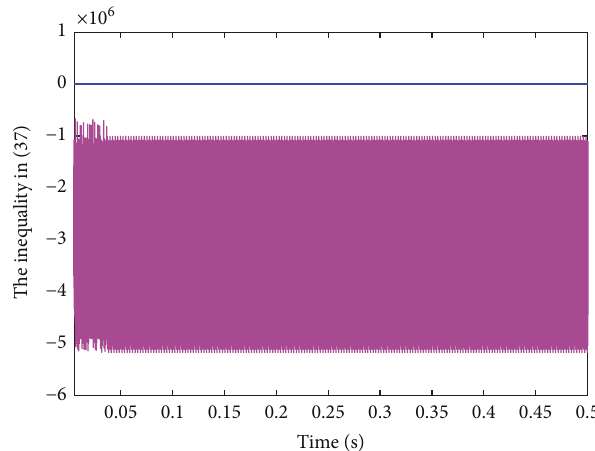
Figure 8: Steady-state for the inequality in (37) with the proposed surface. Table 1: Buck converter